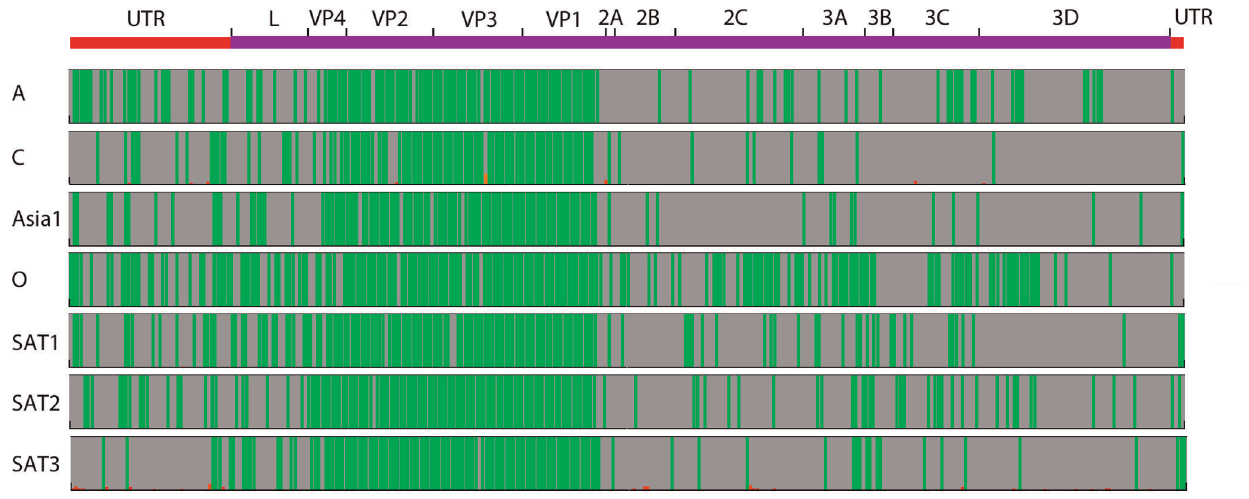
Figure 5. Signature analysis of Foot-and-Mouth Disease Virus (FMDV) serotypes. A fragmented alignment was performed with 50/25 settings using BLASTN (BLAST + ). Target groups were formulated according to the serotype definitions. All other serotypes were used as background. The ‘maximum background/average target’ setting was used for biomarker score calculation. The annotations shown come from the type Asia 1 isolate IND 13–91(DQ989312). VP1–VP4 constitutes the capsid proteins that are exposed on the virus particle and are therefore important determinants for serotype classification.